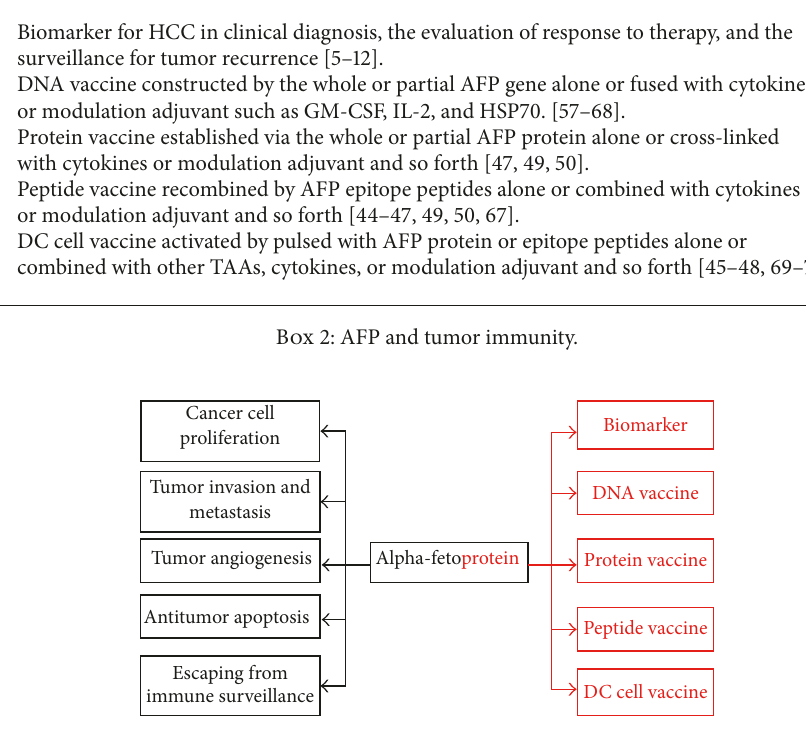
Figure 2: AFP-a sword with two blades . As an oncofetal antigen and diagnostic marker for liver cancer, AFP is a sword with two blades. AFP promoted tumor proliferation, invasion, angiogenesis, and escaping from immune surveillance, which could be an ideal target for immunotherapy. On the other side, AFP-modified DNA, protein, peptide vaccine, or DC cell vaccine displayed the specific antitumor immunity against AFP-positive liver